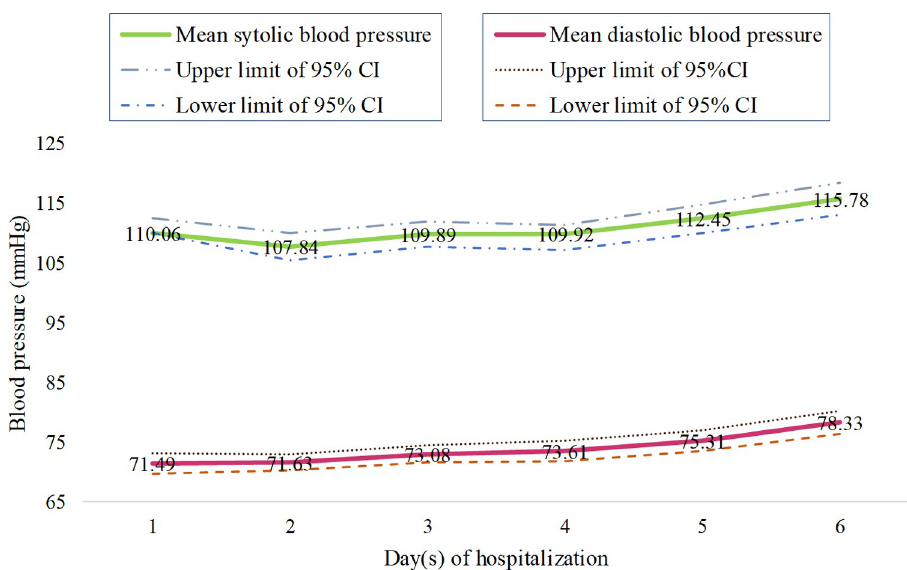
Fig 2. Mean blood pressure of patients (both systolic and diastolic) at the consecutive day(s) of hospitalization.